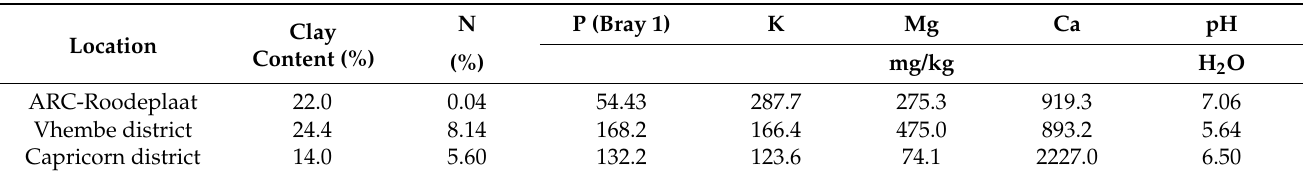
Table 1. Chemical characteristics of soils collected from Moringa oleifera plantations in three growing areas in South Africa during the 2020 growing